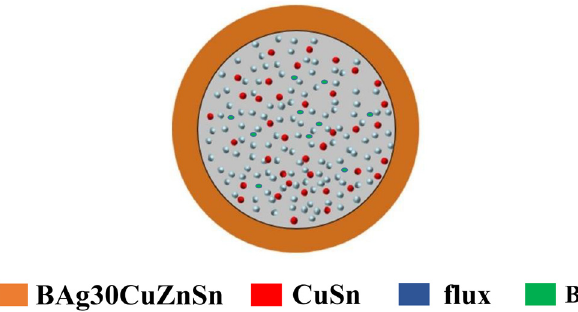
Figure 1: Schematic of the structure of the composite fl ux - cored Ag base fi ller metal.